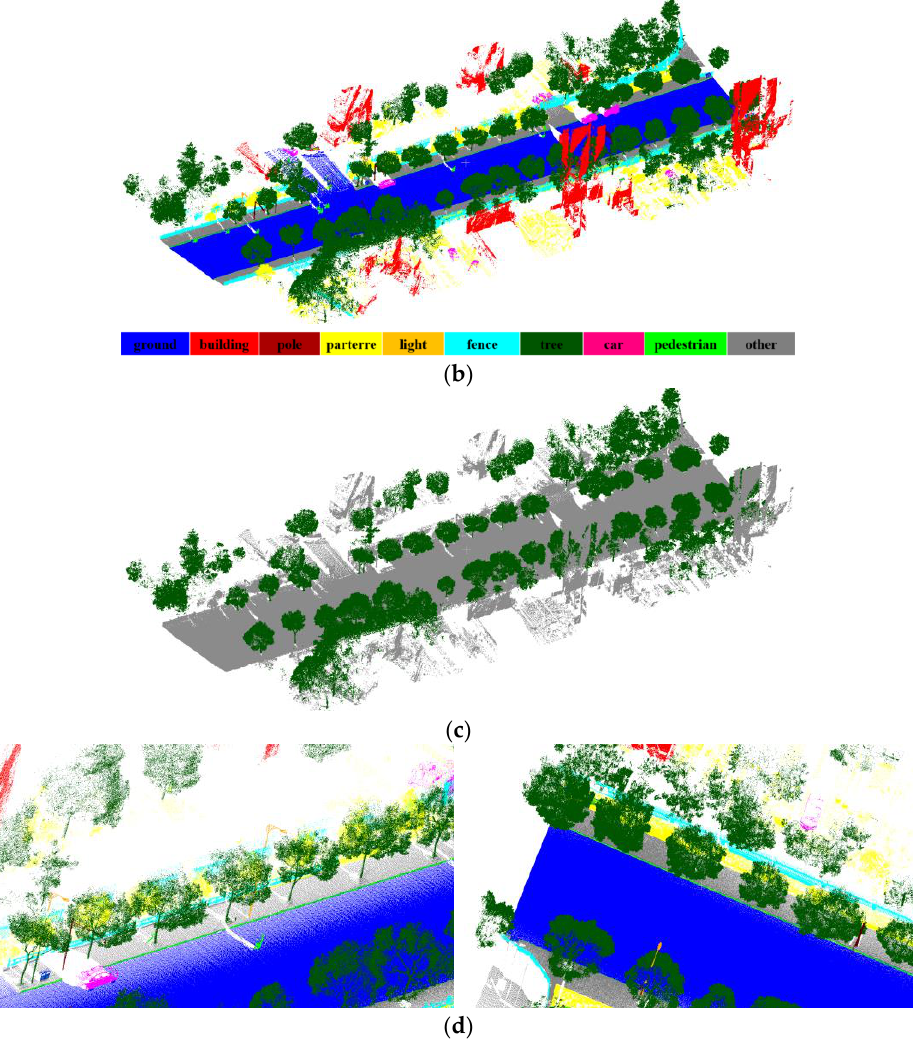
Figure 6. Example of urban MLS point cloud semantic segmentation on Dataset I. ( a ) Raw urban MLS point cloud, ( b ) point cloud semantic segmentation result, dotted in different colors according to the labels, ( c ) tree point extraction result, where green and gray points represent points from trees and non-tree objects, respectively, ( d ) two close-up semantic segmentation results at some selected regions.